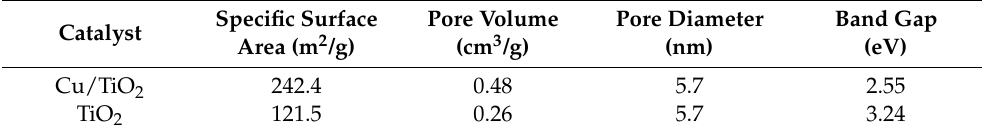
Table 2. Textural properties and band-gap energies of Cu/TiO 2 and TiO 2 catalysts.